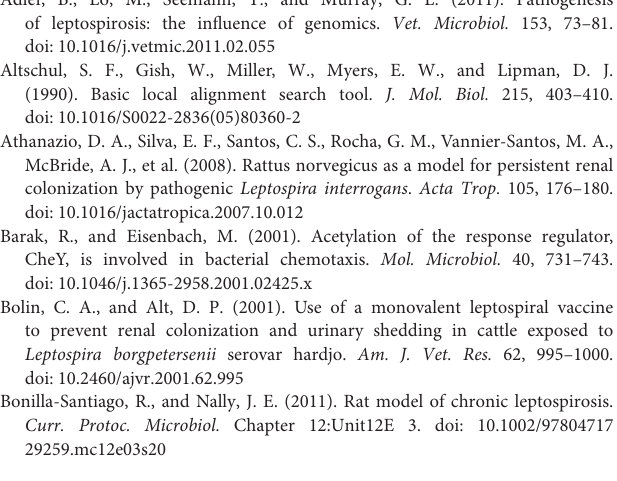
provides all significant hits which are highlighted in green, and proteins spots with more than one significant identification are highlighted in yellow.